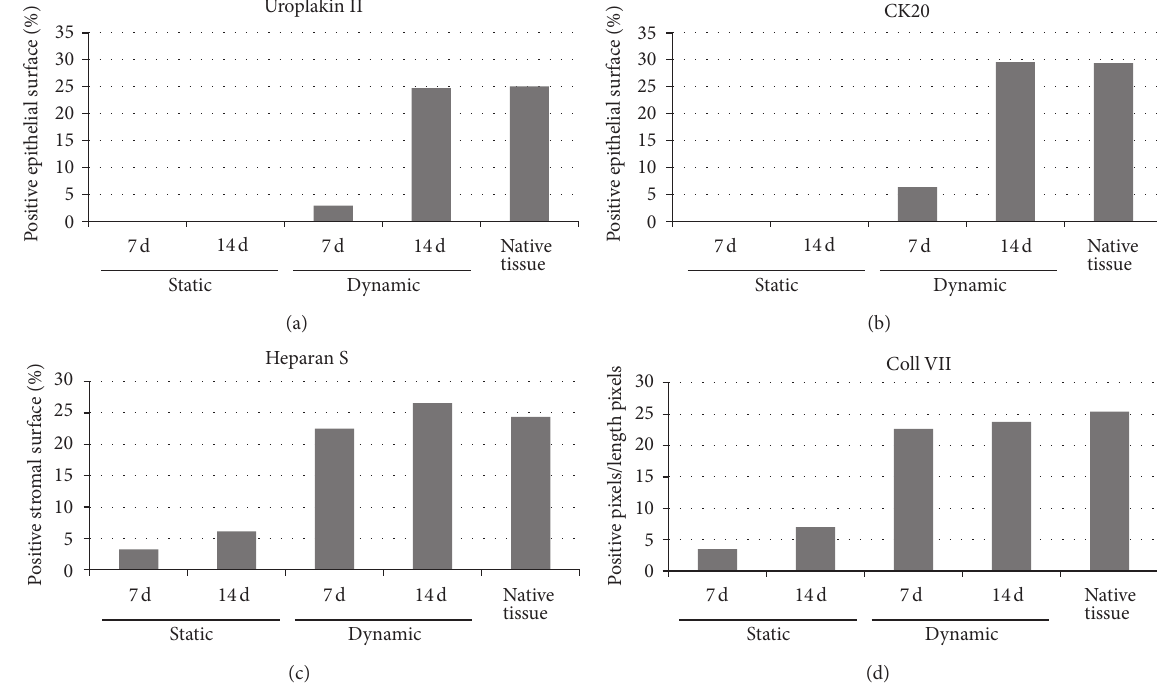
Figure 4: Mechanical stimuli-induced urothelial differentiation in a human tissue-engineered tubular genitourinary graft. Data from immunofluorescence were raised against the indicated molecule as presented in Cattan et al. [48]; they were analyzed with NIH ImageJ software. In (a) percentage of uroplakin II positive surface relative to the urothelial surface is depicted without stimulation (static) at day 7 (7d), or day 14 (14d), or with mechanical stimulation (dynamic) and compared with a native porcine tissue. In (b) similar data are presented for cytokeratin 20 (CK20). In (c) heparan sulphate (Heparan S) positive surface was evaluated compared to stromal surface. In (d) data depict collagen VII (Coll VII) positive pixels relative to the length in pixel of the basal